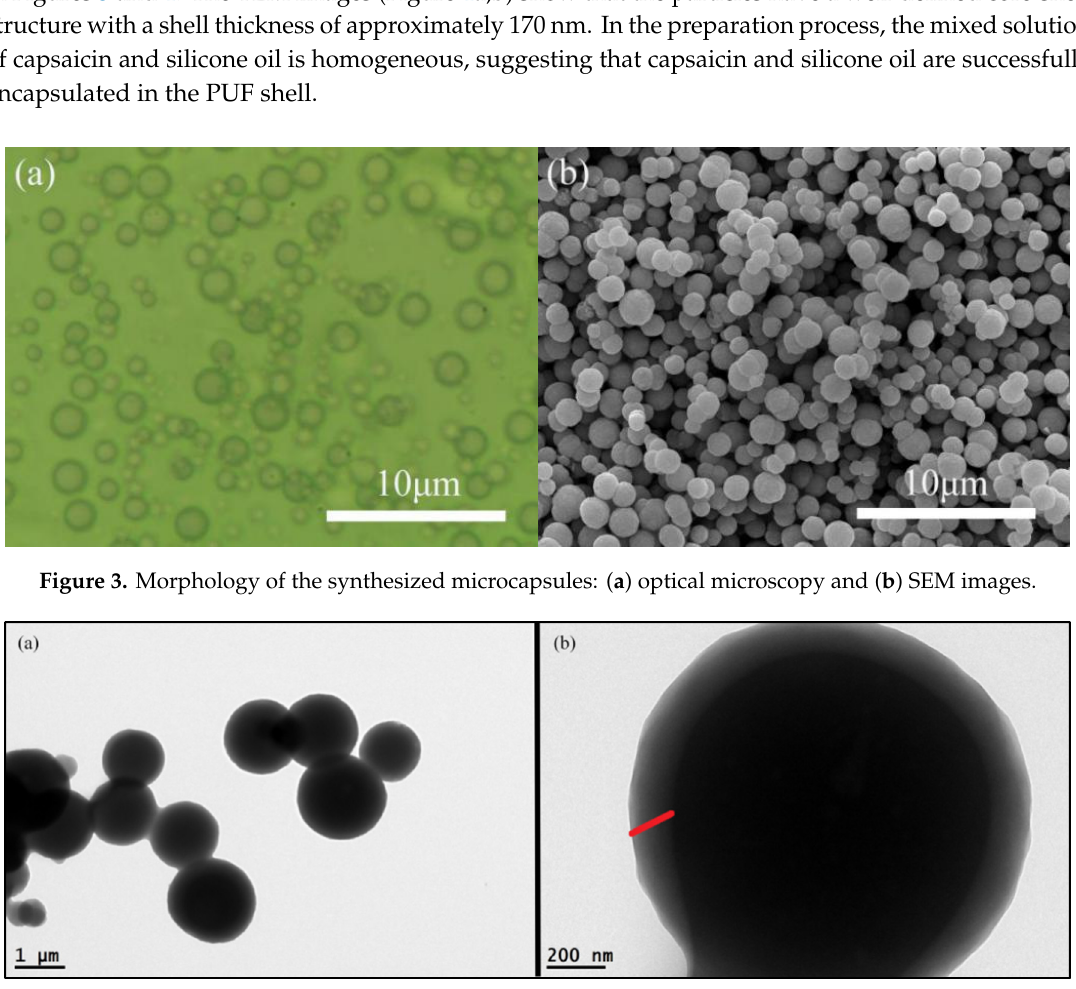
Figure 4. TEM images of the synthesized microcapsules. ( a ) ×8000 times; ( b ) ×40000 times.